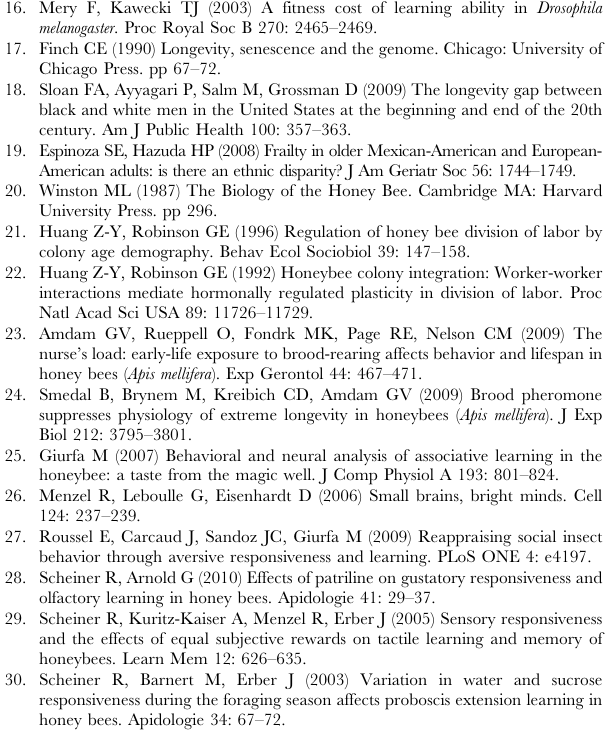
Figure S1 (A) Worker honeybee prepared for testing of Pavlovian learning ability. The restraint holder is custom-made from Plexiglas, and the bee was affixed with straps of tape. After quantification of gustatory responsiveness and learning, the straps were removed and the bee was released unharmed. (B) Worker bee in the modified Eppendorf tube design used in our assay of survival capability in hyperoxia. The lid has holes for feeding and air- exchange. The end of the tube is cut open and sealed with cotton to absorb animal waste. Found at: doi:10.1371/journal.pone.0009740.s001 (10.12 MB TIF) Figure S2 Relationship between the outcome of the retention test, where bees were monitored for specific CS memory, and survival time in hyperoxia (80% O2). Bars are averages + S.E. for survival time (hours). Specific CS memory for the conditioned stimulus (carnation) was measured after olfactory conditioning by presenting the bees with an alternative odour (cineole) one time. No (zero) proboscis extension response (PER) to the alternative odour demonstrated specific CS memory. The performance in the retention test was not associated with survival time in hyperoxia (Student t-test; t = 2 0.022, P = 0.983). Sample sizes inside bars. Found at: doi:10.1371/journal.pone.0009740.s002 (0.01 MB